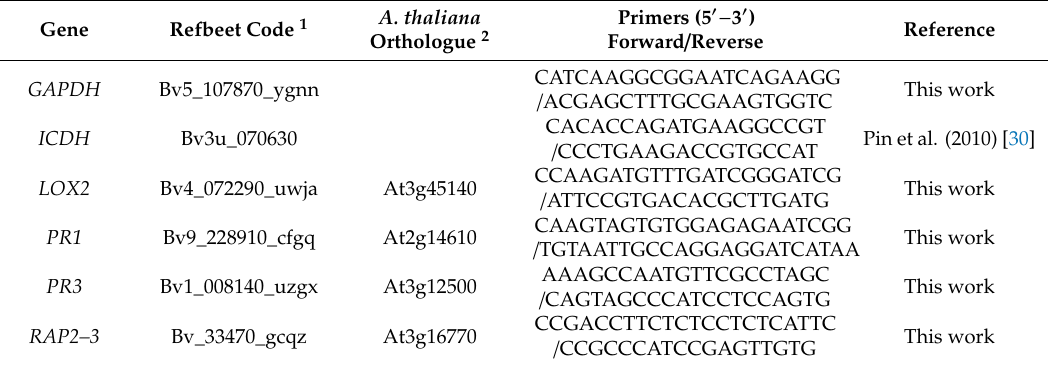
Table 1. Primer pairs used.